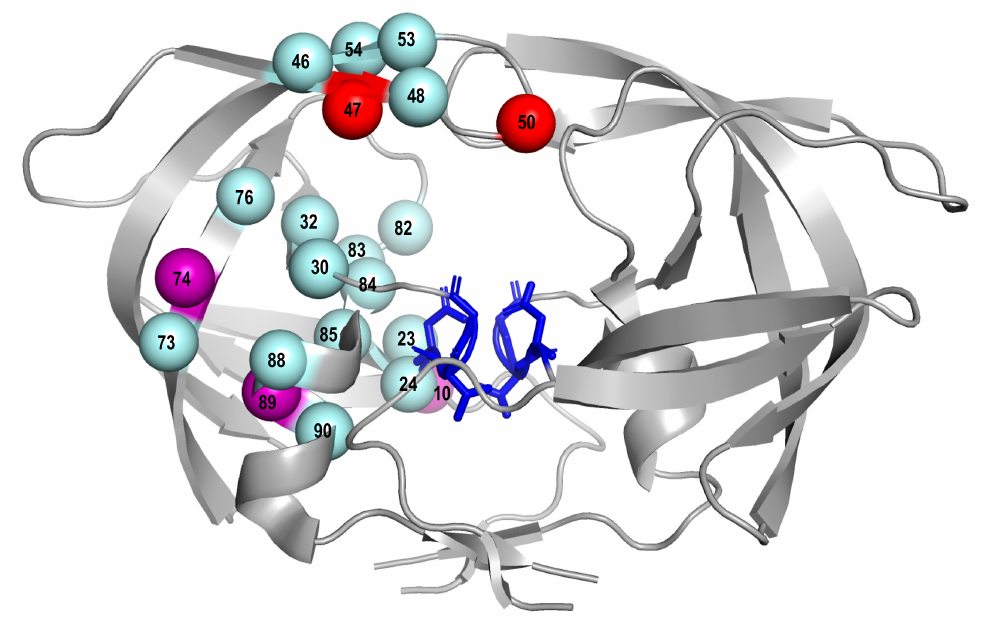
Figure 3. Three-dimensional structure (PDB accession number 1MUI) of HIV-1 protease showing in grey. The active site residues D25, D26, and D27 are shown in stick mode in blue. Red spheres indicate two SDRM positions at which SDRMs (V47A and I50L) increased in prevalence since 2009 in PI-experienced persons. Three purple spheres indicate darunavir-associated candidate SDRMs including L10F, T74P, and L89V. Spheres in cyan indicate SDRM positions at which SDRMs decreased or did not change in prevalence since 2009 in PI-experienced persons. HIV-1 protease is a homodimer and amino acid positions are indicated only on one monomer of the homodimer for